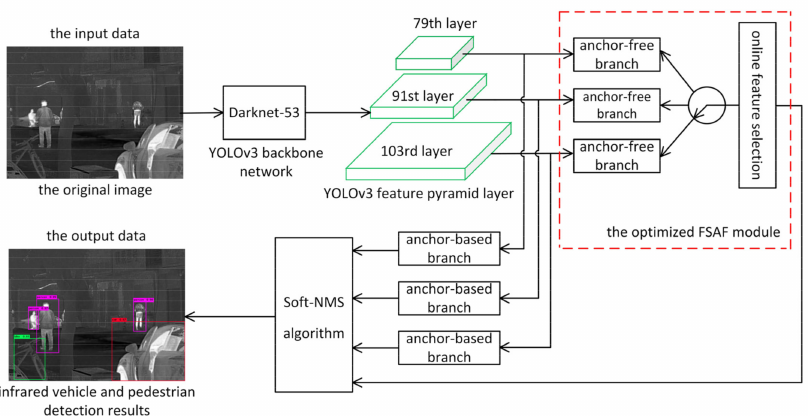
Figure 1. Overview of the proposed method. The optimized feature selective anchor-free (FSAF) module is plugged into the you only look once (YOLO)v3 network structure and works jointly with the anchor-based branches of the YOLOv3